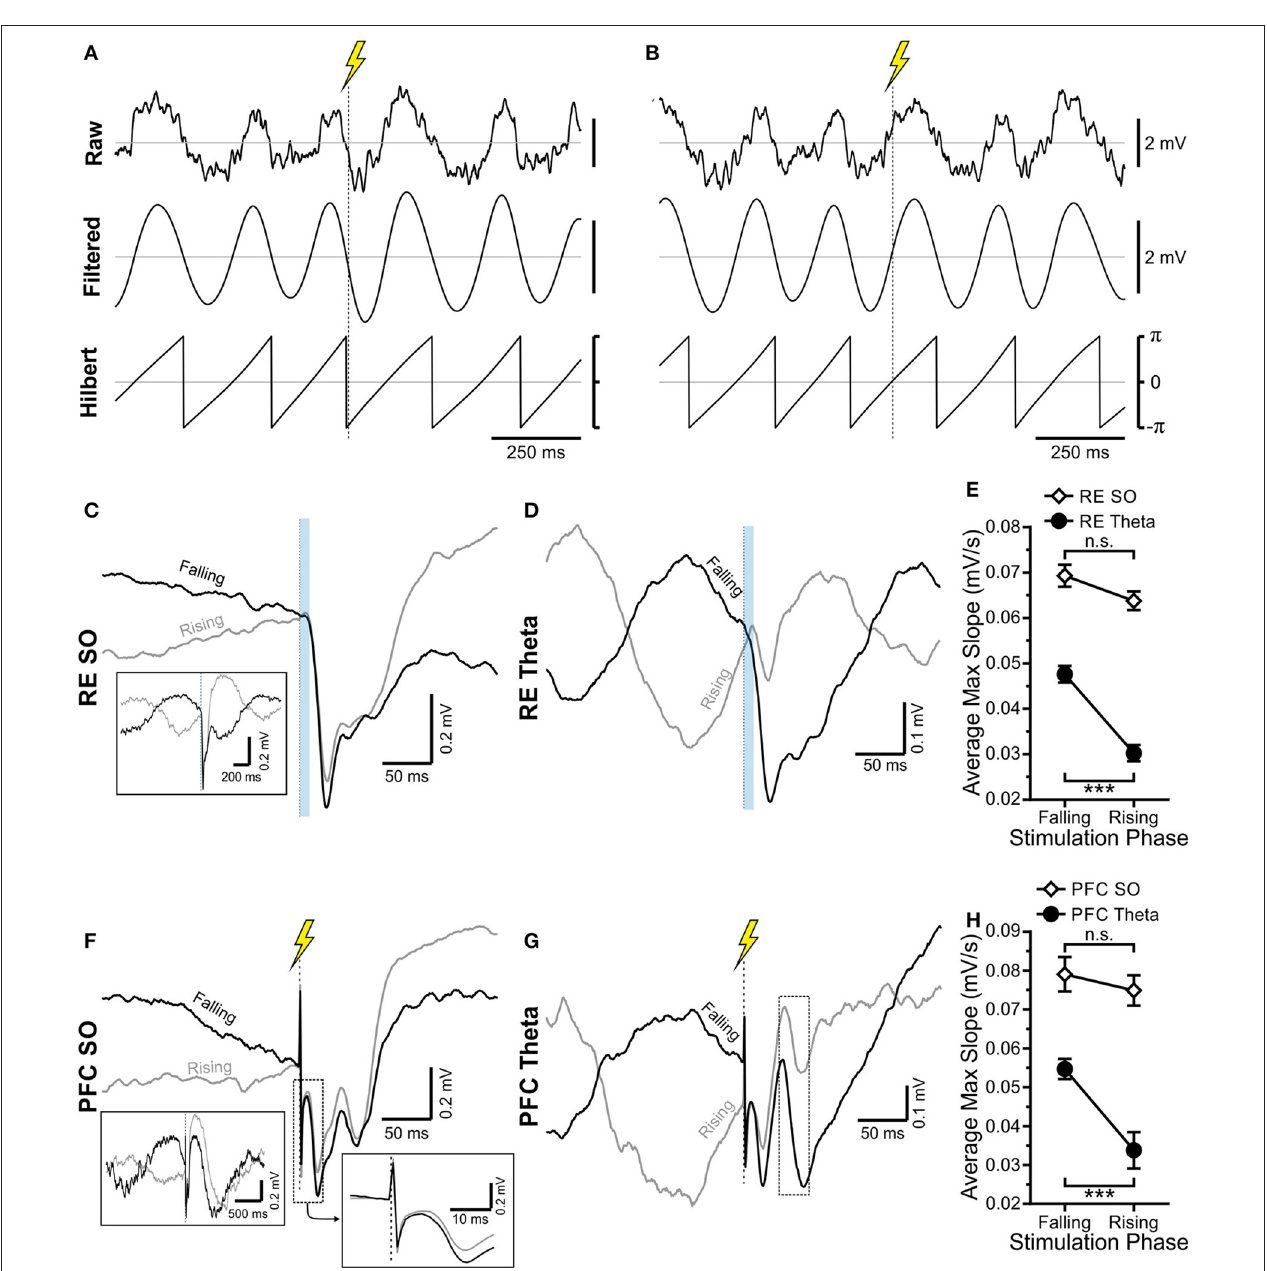
FIGURE 7 | HPC is differentially excited by stimulation during the falling or rising phase of the theta and SO rhythms. (A) Raw local field potential recording, 3–6Hz bandpass filtered signal, and Hilbert transformed signal of the same ∼ 1.5s of HPC theta. Stimulation is indicated by a vertical dashed line with a lightning bolt above it. Stimulation is being delivered during the falling phase of the oscillatory cycle. (B) Identical to (A) except that stimulation is being delivered on the rising phase of the oscillatory cycle. Scale bars are identical in (A) . (C,D) RE stimulation (10ms optical pulse) being delivered during the falling (black) or rising (gray) phase of the ongoing SO cycle (C) and theta cycle (D) , with average, evoked local field potential (LFP) at SLM shown. Stimulation in both states produces an obvious evoked response, which appears larger when stimulation is delivered on the falling phase of the rhythm. (C) Provides a larger timescale for easier visualization of the rising or falling phase of the SO cycle. (E) Maximum evoked slope averaged over every IL stimulation trial during SO (unfilled black diamonds) and during theta (filled black circles). The maximum slope is significantly greater during theta when stimulation is delivered on the falling phase, while no significant difference is observed during SO. However, regardless of phase, stimulation during SO always yields a larger response. (F,G) The same as (C,D) , but with an electrical instead of the optical pulse, to infralimbic (IL) zones. Stimuli are delivered either on the falling (black) or rising (gray) phase of the SO (F) or theta (G) cycle. The dashed box in each corresponds to the approximate time window for evoked potential analysis. (H) As is the case with RE stim in (E) , IL stimulation delivered on the falling phase of theta (black, filled circles) produces a significantly larger maximum slope on average than equivalent stimulation delivered during the rising phase. No significant difference between stimulation phases is observed during SO (hollow black diamonds), although stimulation during SO always yields a larger response than stimulation during theta, regardless of the oscillatory phase.